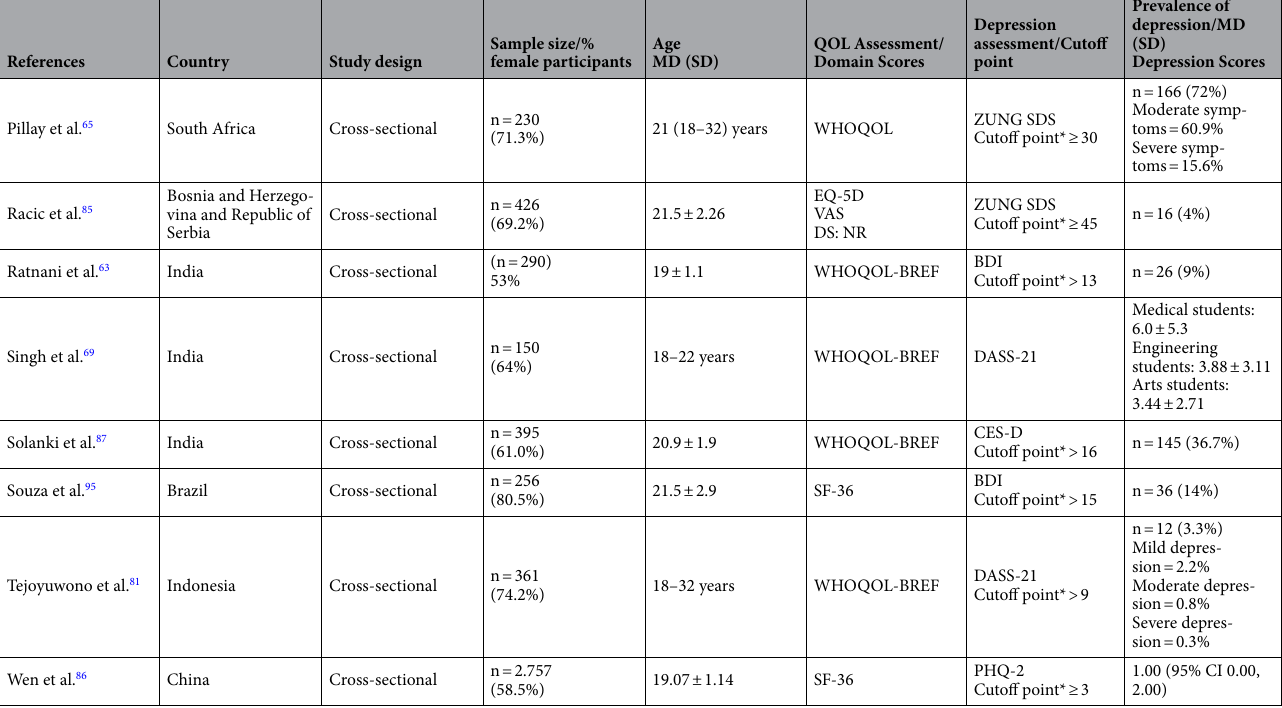
Table 4. Characteristics of the studies included and their outcome variables. ADRS: Adolescent Depression Rating Scale; CES-D: Center for Epidemiological Studies Depression Scale; DASS: Depression, Anxiety, and Stress Scale; DS: Domain scores; EQ-5DVAS: Visual Analogue Scale; ES: Effect size; HADS: Hospital Anxiety and Depression scale; HRQOL: health-related quality of life; CI: confidence interval; MHI-38—Mental health inventory; NR: not reported; OK-ados: OK-ados questionnaire; OR: odds ratio; PedsQL: Pediatric Quality of life Inventory; PHQ: Patient Health Questionnaire; QOL: quality of life; RAND 36-Item Health Survey; RCADS-P: Revised children anxiety and depression scales, parent form; SF-8: Optum Short Form-8 Health Survey; SF-36: Short Form Health Survey; TSCC: Trauma Symptom Checklist for Children; WHOQOL: The World Health Organization Quality of Life Questionnaire; WHOQOL-BREF: The World Health Organization Quality of Life Questionnaire—short version; WHOQOL-BREF-THAI: The World Health Organization Quality of Life Questionnaire—Thai version; YQOL-SF: Life Instrument-Short Form; ZUNG SDS: Zung self- rating depression scale. T, reference for the data collection period in the longitudinal study. *, reference value for the presence of depressive